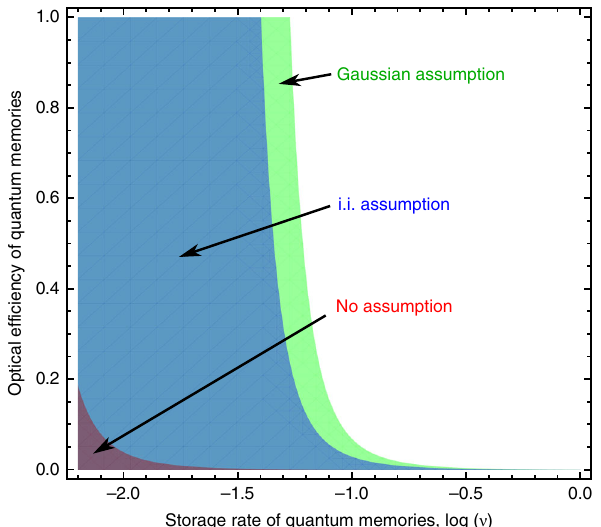
Fig. 2 Oblivious transfer security regions. The secure regions are obtained for different assumptions imposed on the encoding operation of malicious Bob ’ s quantum memories. We plot optical ef fi ciency η of the quantum memories versus the logarithm to basis 10 of the quantum memory storage rate ν . Security is obtained for all values of ν and η marked by the colored regions. The green region is obtained under the assumption that the encoding is Gaussian ( n = 2 × 10 5 , β = 0.944, δ = 0.1), the blue region under the assumption that the encoding is independent and identical over at most m E = 10 modes ( n = 10 8 , β = 0.944, δ = 0.1), and the red region without any assumption, i.e. arbitrary encodings ( n = 10 8 , β = 0.98, δ = 1.0). The plots are obtained for an EPR source with two-mode squeezing of 12 dB and losses on Alice ’ s and Bob ’ s side of 3 and 6%, respectively. Further parameters: ϵ A = 10 − 7 , α cut = 51.2 and Bob ’ s maximal photon number in the encoding is assumed to be smaller than